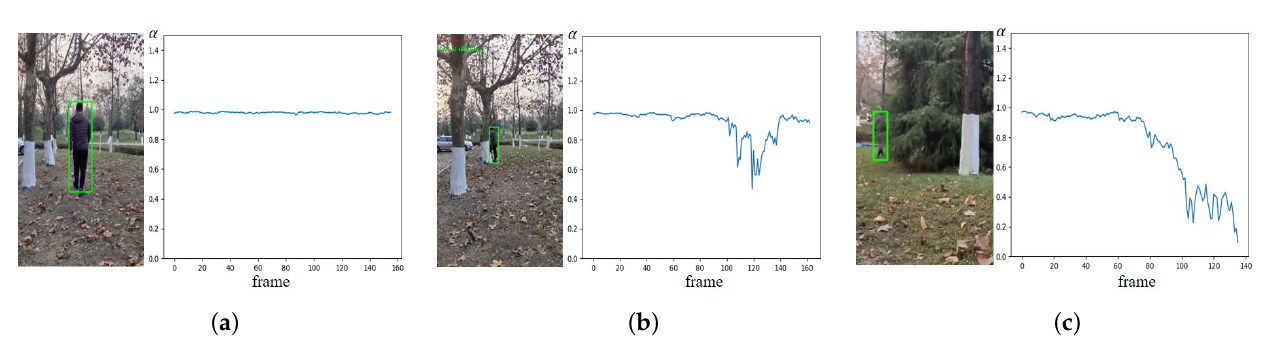
Figure 4. The variation of tracking confidence α . ( a ) normal. ( b ) short-term occlusion. ( c )